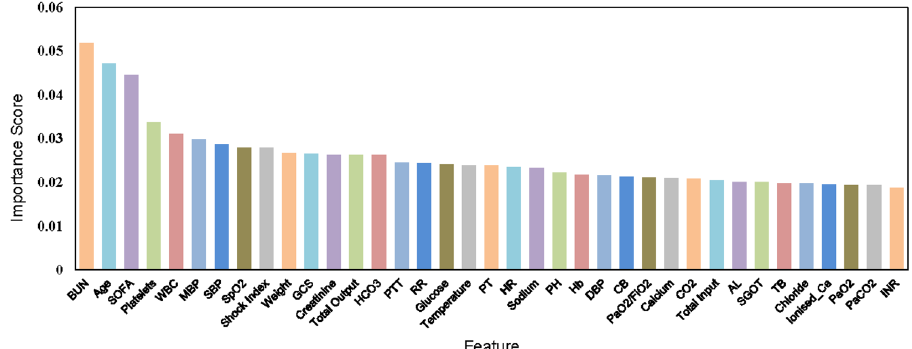
Fig. 6 Feature importance score. We calculate the classi fi cation accuracy with death as the label for different numbers of features. The 37 features (variables) selected with the highest accuracy are displayed. The glossary of vital signs and lab values is provided in Table